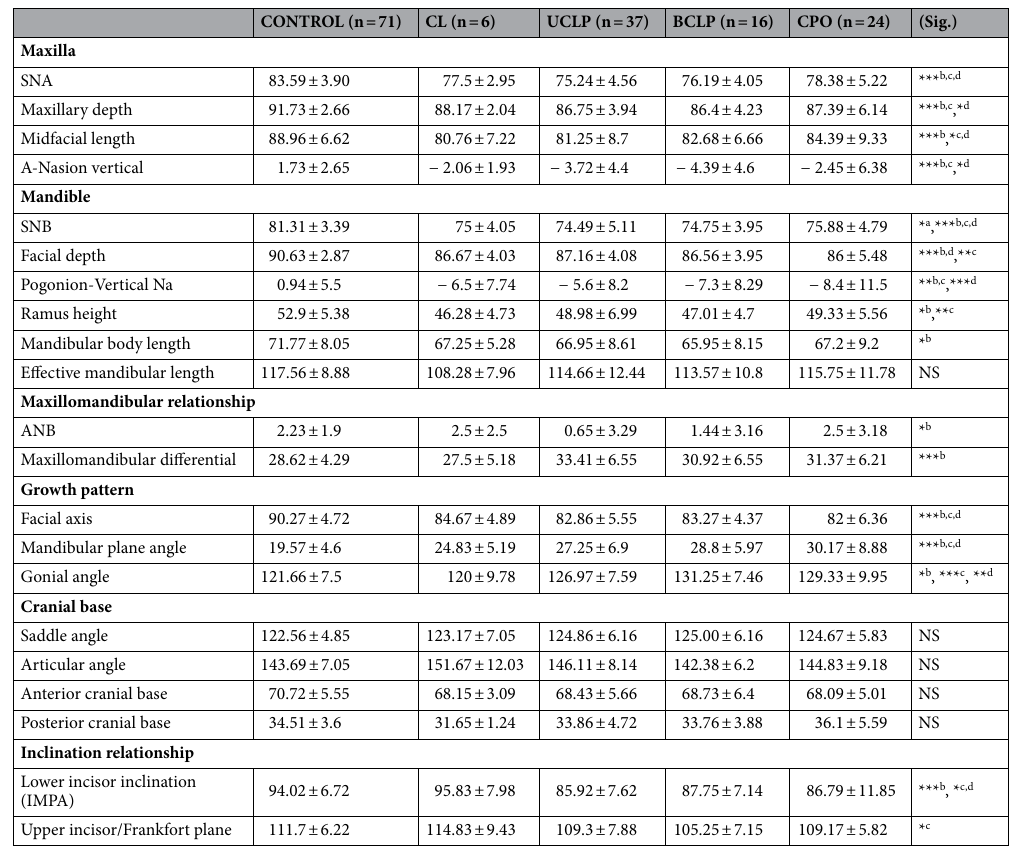
Table 2. Comparison of cephalometric measurements between groups. Sig. statistical significance, NS not significant. * p ≤ 0.05; ** p ≤ 0.01; *** p ≤ 0.001. a Controls versus CL. b Controls versus UCLP. c Controls versus BCLP. d Controls versus